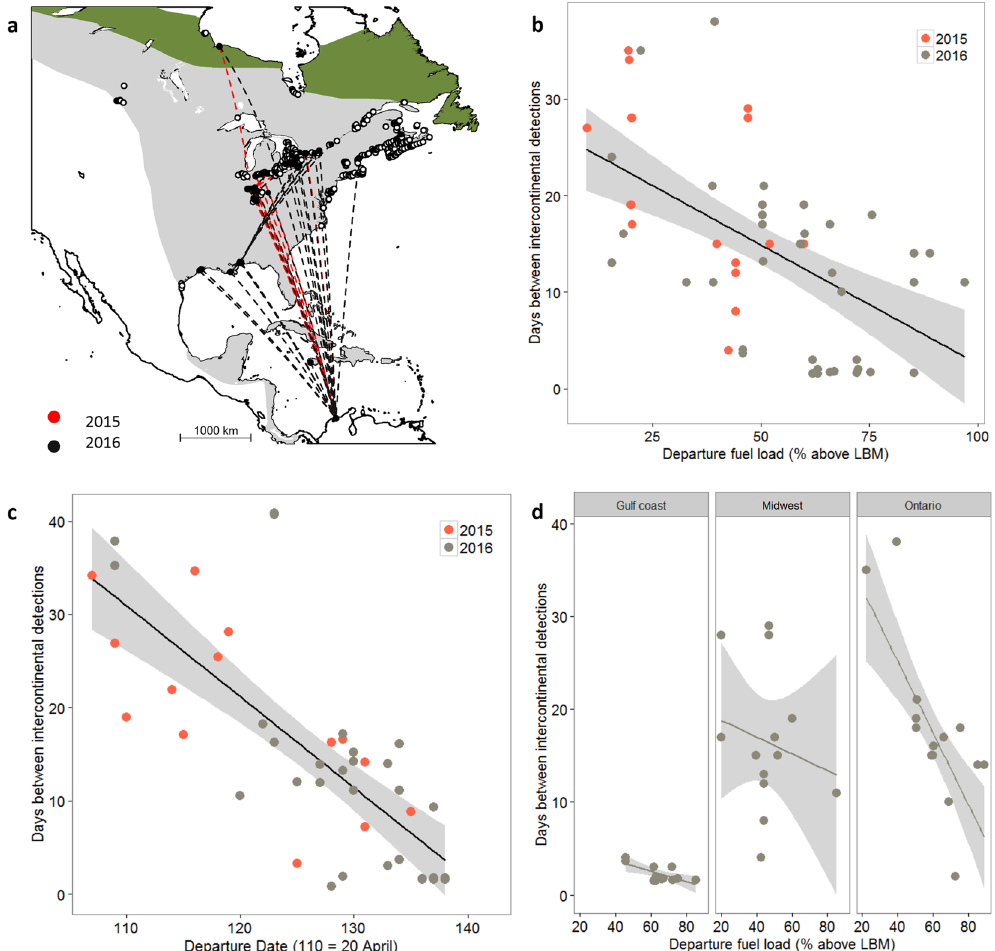
Figure 3. Evidence for an effect of departure fuel loads and departure date on the subsequent pace of migration. ( a ) 43 radio-tagged Grey-cheeked Thrush were detected in North America by automated receivers. Dashed lines connect the great arc distance between detections but they should not be interpreted as flight trajectories. 30 birds were detected on multiple occasions, all of which show a strong north-east shift in direction after first detection. Map generated using ‘maptools’ version 0.8–39 in R 90, 104 (https://cran.r-project. org/package = maptools). ( b , c ) We found a strong negative relationship between departure fuel load ( b ) and departure date ( c ) on the pace of migration, measured by the number of days elapsed between intercontinental detections of Grey-cheeked Thrush departing from northern Colombia. Shaded areas represent 95% confidence intervals. ( d ) The best model supported a significant effect of the geographic region where the detections occurred as determinants of the pace of migration after accounting for the effect of departure fuel load (Gulf coast: n = 12, Midwest: n = 13, Ontario: n = 14). The magnitude of the region effect increased with increasing distance from Colombia, suggesting a negative carry-over effect on the pace of migration after the Caribbean- Gulf